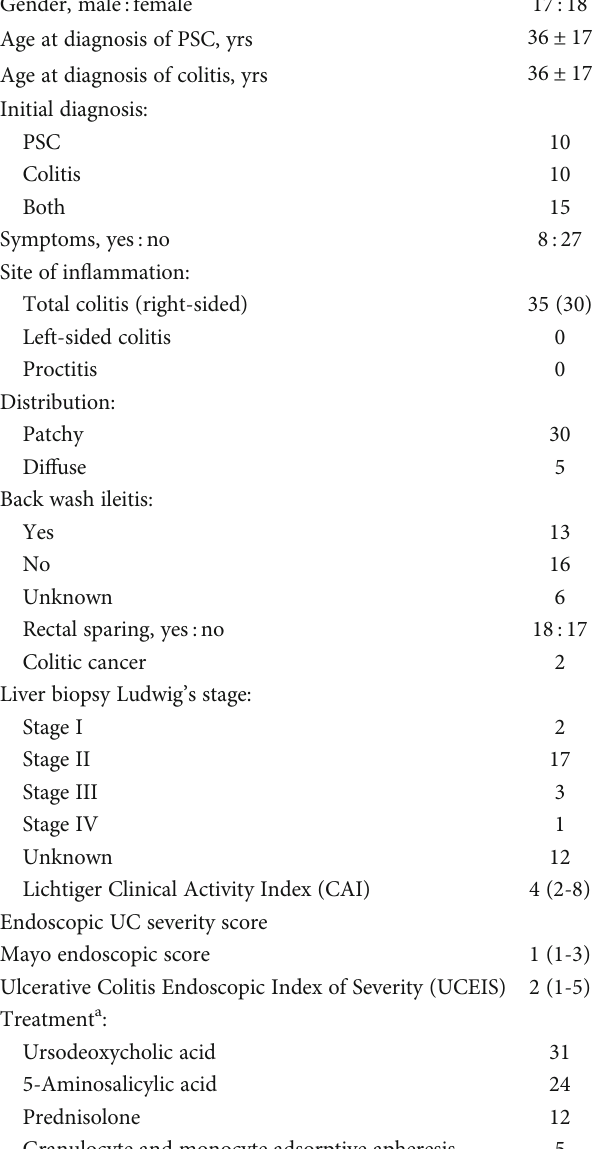
Table 2: Clinical characteristics of the PSC patients with concurrent UC ( n = 35